Question: What kind of plot is shown here?
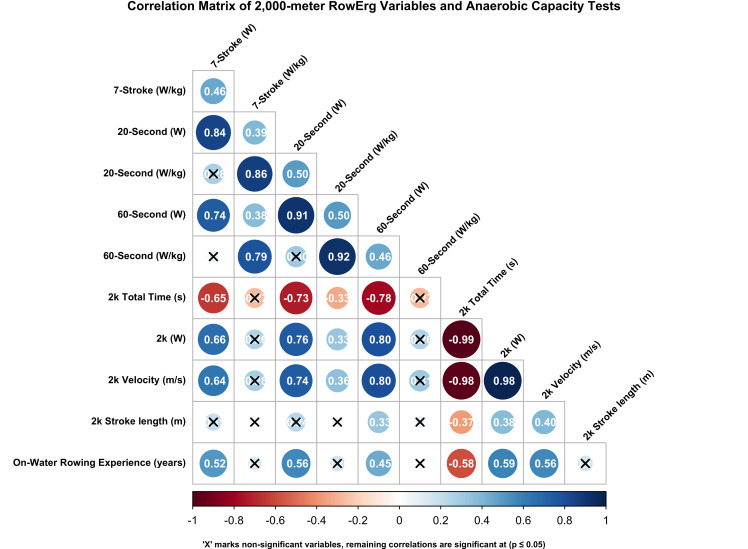
Answer: heatmap